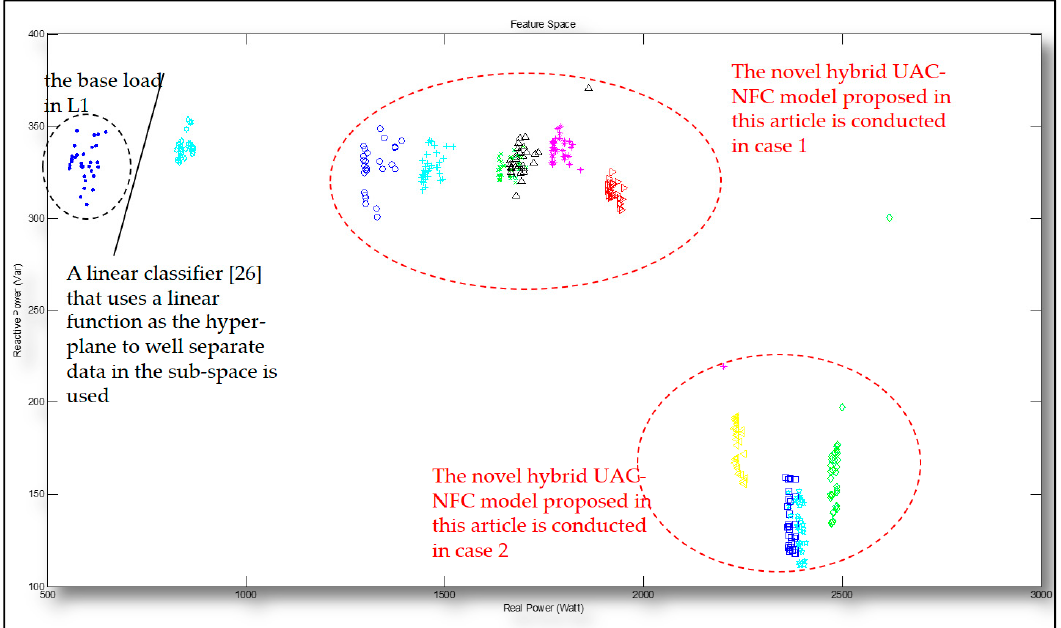
Figure 7. Feature space being of real power (P) and reactive power (Q). There are 12 classes in the feature space, which are marked by different color.